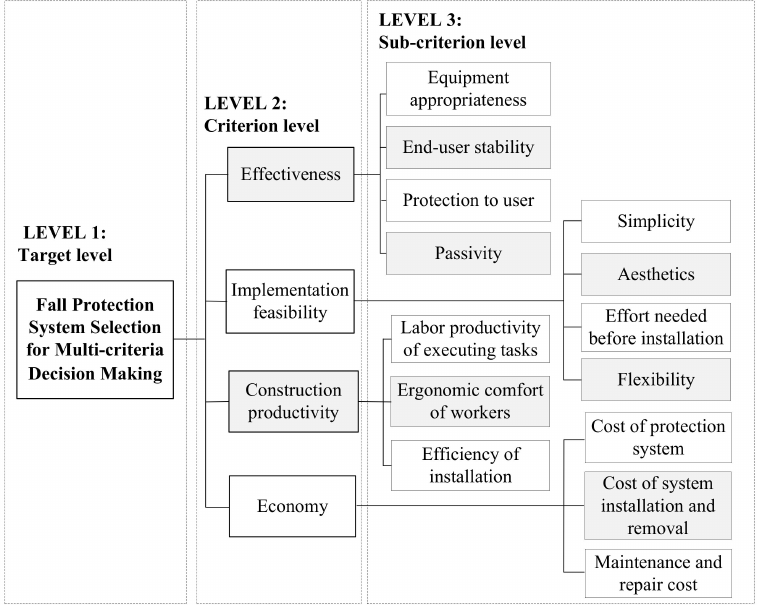
Figure 2. Hierarchy structure of evaluation criteria affecting the fall protection plan selection for a construction